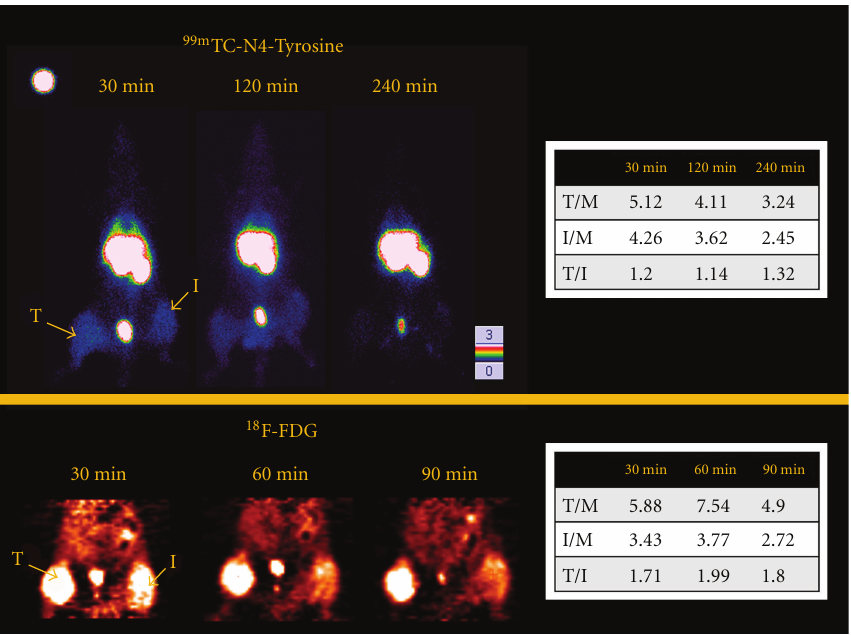
Figure 6: The selected planar scintigraphic images of breast tumor- and inflammation-bearing rats at 30, 120, and 240 minutes after 99m Tc- N4-Tyrosine injection and micro-PET images at 30, 60, and 90 minutes after 18 F-FDG injection (T indicates tumor; I, inflammation). Tumor-to-muscle (T/M), inflammation-to-muscle (I/M), and tumor-to-inflammation (T/I) ratios are shown in the